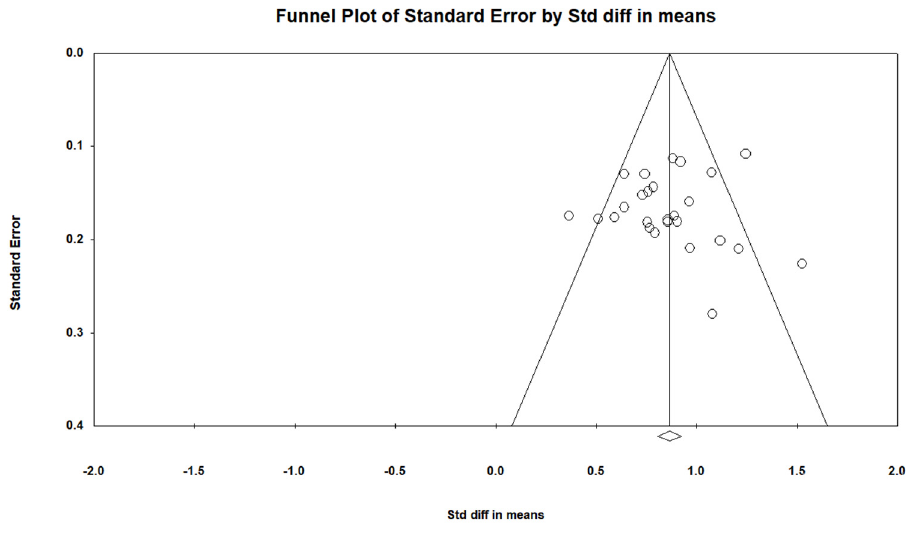
Figure 3. Funnel plot for SDMT